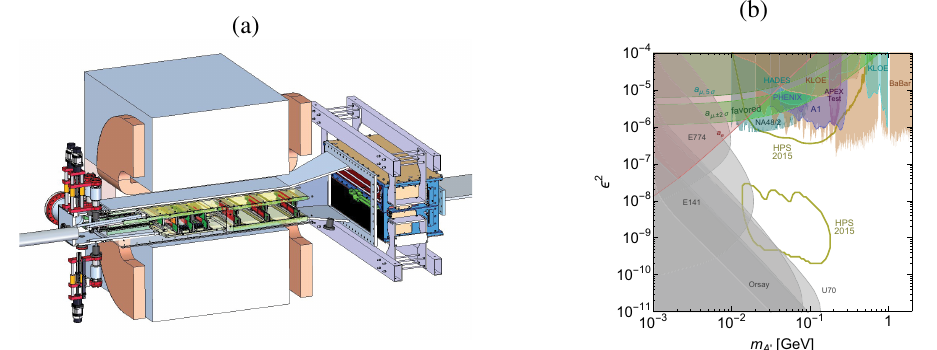
Figure2. HPSdetectorsetup. Fromlefttoright: thefirstdipolemagnet,thetargetsystem,theSVTinsidetheanalyzingmagnet,the ECalandthethirddipolemagnet.